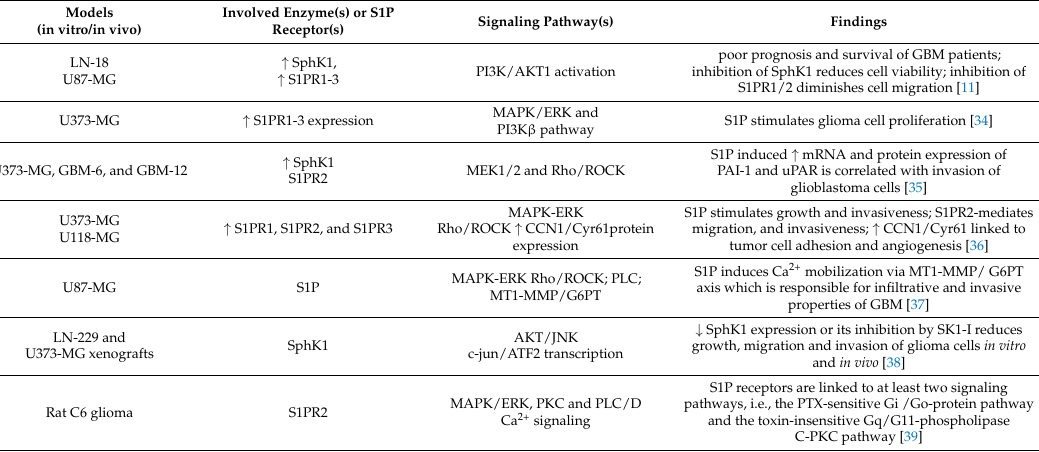
Figure 2. Schematic diagram depicting guanine nucleotide-binding protein (Gi)-mediated S1PRs activation and multiple signaling pathways in glioblastoma. S1PRs via stimulation of the Gi may simultaneously activate MAPK-ERK1/2, c-jun N-terminal kinases (JNK), phospholipase C (PLC), phosphoinositide 3-kinase (PI3K) and p38 pathways in glioma cells. Following the activation of downstream signaling, ERK1/2 facilitates the co-expression and activation of c-jun, c-fos and the early growth response (Egr-1)/fibroblast growth factor (FGF-2) system respectively. Cell cycle arrest by CCND2 (cyclin D2) gene expression and the PLC/Ca 2+ system is responsible for proliferation. Sphingosine kinase 1 (SphK1) signaling is necessary for the maintenance of urokinase plasminogen activator (uPA) expression and the basal invasive activity of glioma cells by a receptor-independent mechanism. While phosphorylation of SphK1 by ERK1/2 regulates S1P production and spiral signaling PI3k/ATK pathways through the activated downstream targets, mechanistic target of rapamycin (mTOR) and metalloproteases (MMPs) lead to angiogenesis and survival. On the other hand, p38 signaling induces migration. Additional abbreviations used in the figure are defined as follows: DAG, diacylglycerol; ERK1/2, extracellular signal-regulated kinase 1 and 2; Gi, guanine nucleotide-binding protein; IP3, inositol-1, 4, 5-triphosphate; MEK, mitogen-activated protein kinase; PI3K, phosphoinositide 3-kinase; PKC, protein kinase C; PLC, phospholipase C; ↑ , increased. Table 1. Summary of S1P enzyme(s) or receptor(s)-mediated effects in GBM. Models InvolvedEnzyme(s)orS1P (invitro/invivo) Receptor(s)